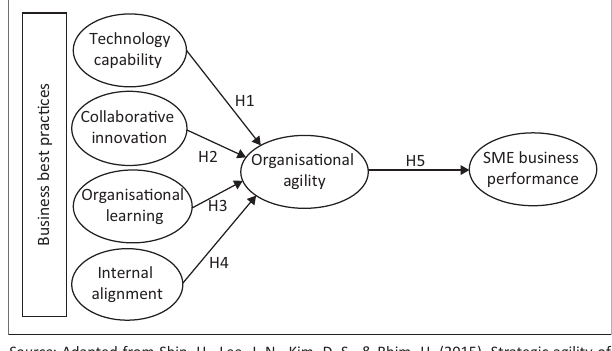
FIGURE 1: Conceptual framework for organisational agility, business best practices and